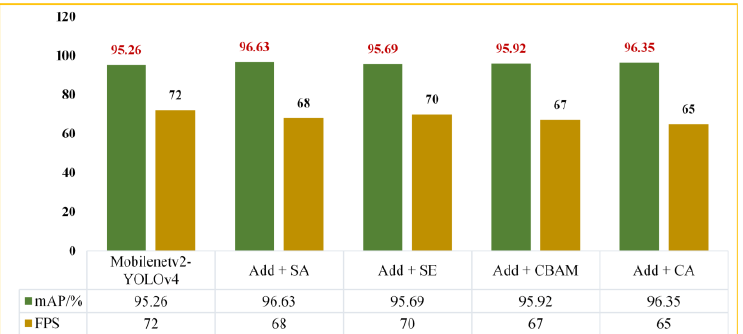
Figure 12. Comparative experimental results for different attention mechanisms.